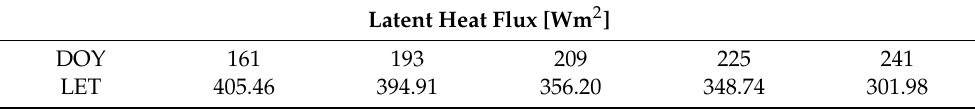
Table 3. Overall mean latent heat flux across Yanqi basin during the understudied